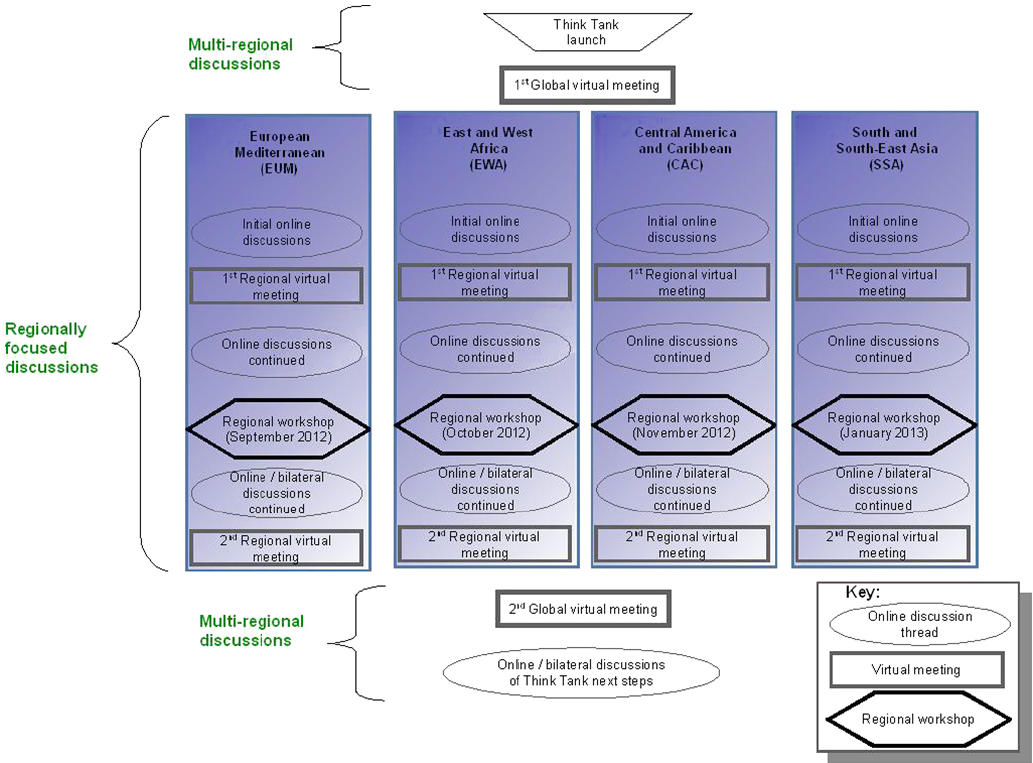
Figure 2. The CATALYST Think Tank process 2012–2013.